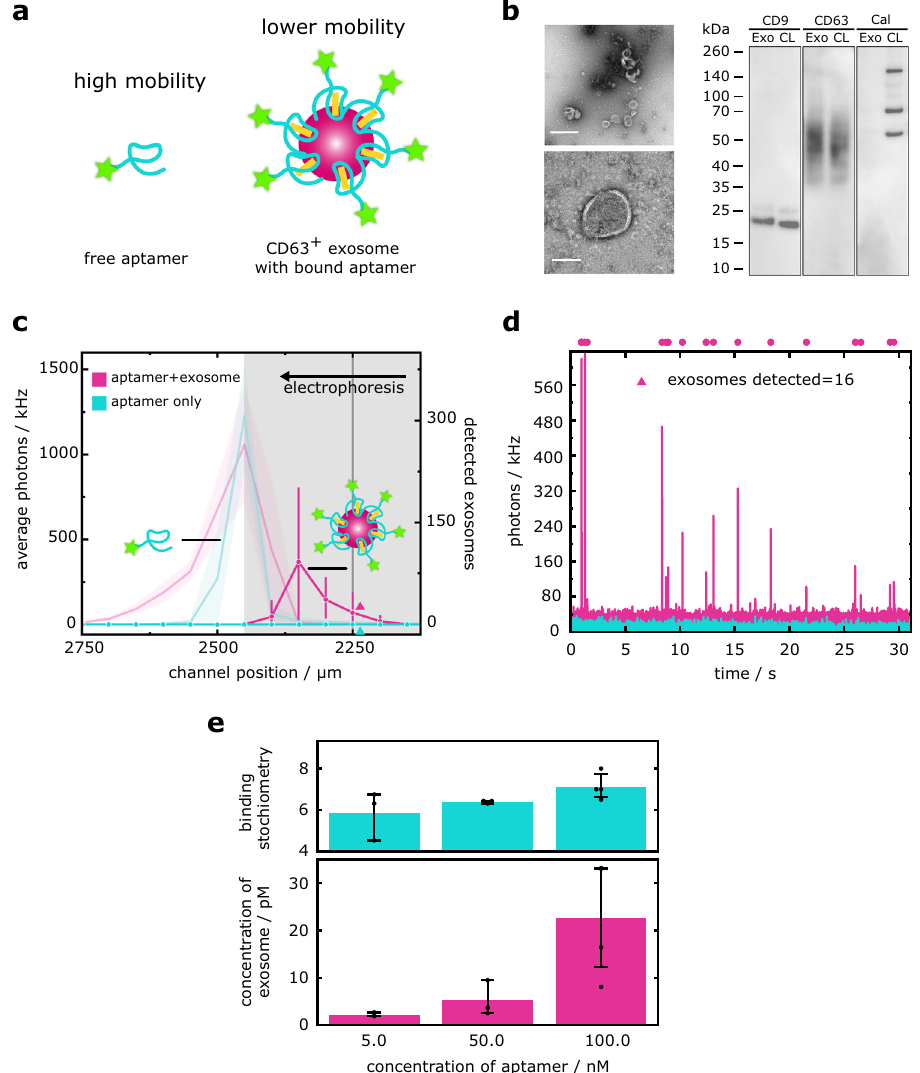
Fig. 6 | DigitISA immunosensing of an exosome biomarker. a Shown is a CD63- speci fi c aptamer bound to CD63 proteins on the surface of the exosomes. The exosome-bound aptamers have a lower electrophoretic mobility than the free aptamers, allowing for the discrimination between exosome-bound and unbound species. b TEM micrographs (left panels) and Western blots (right panels) of exo- somes. Exosomes display their characteristic cup-shaped morphology and can be identi fi edbytheirsize(100 – 200nmindiameter)andthepresenceofalipidbilayer membrane. TEM experiments were repeated three times. Scale bars: 500nm (top left), 100nm (bottom left). Western blot (right panels) comparing exosome sam- ples (Exo) and cell lysate sample (CL). CD9 and CD63, both exosome marker pro- teins, are highly enriched in the exosome sample, while calreticulin (Cal) is excluded from the exosomes, indicating their purity. Western blot experiments were repeated three times. c Electropherograms as obtained by scanning of the confocal volume across the cross-section of the channel in a stepwise manner for the 50nM exosome – aptamer sample (magenta line; average of N =3 repeats) and